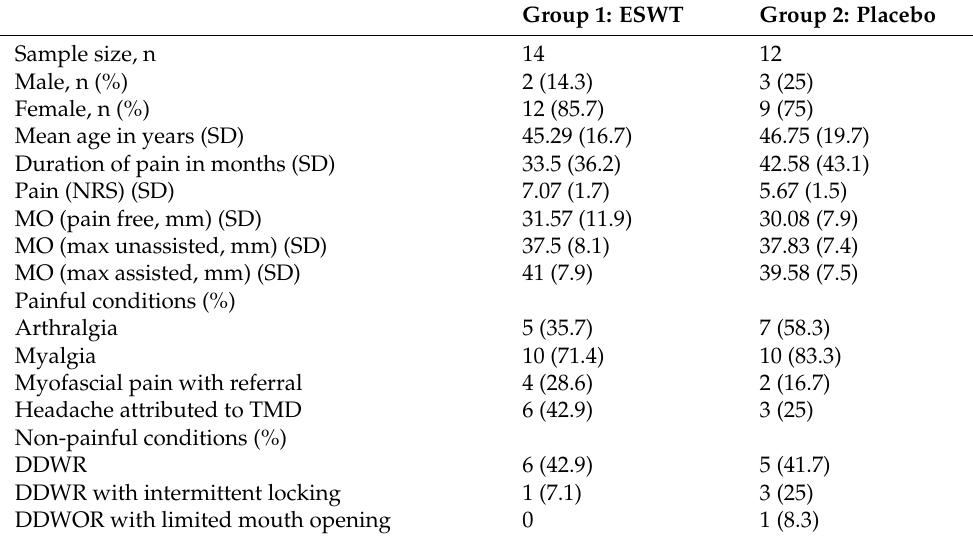
Table 2. Demographic characteristics of the final analysed